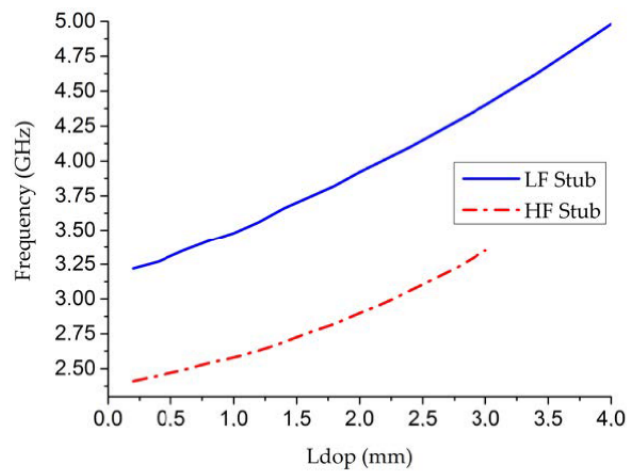
Figure 13. Central frequency of a switchable DBR in the ON state depending on the doped area length, for a central frequency of 5.52 GHz in the OFF state.